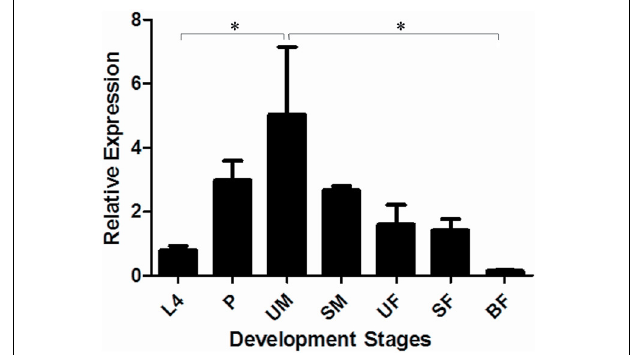
FIGURE 6 | Relativeexpressionoflysozyme(LlLysi)indifferentstagesof development of Lutzomyia longipalpis as determined by Multiplex RT-PCR (Ribosomal protein 60 used as constitutive gene). The experimental groups used in the experiments were larvae (L4), pupae (P), unfedmaleadults(UM),sugar-fedmaleadults(SM),unfedfemaleadults(UF), sugar-fedfemaleadults(SF),andblood-fedfemaleadults(BF).Barsrepresent the mean ± SE from 3 independent experiments. The statistics were done using ANOVA with Turkey post-test and student’s t -test. Asterisks indicate statistically significant differences in the samples.